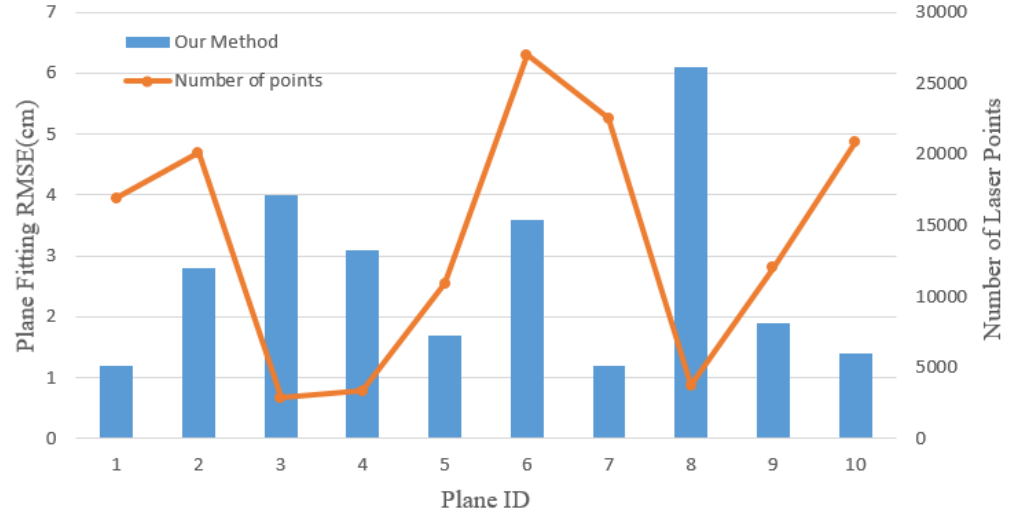
Figure 6. Local mapping quality evaluation according to plane fitting